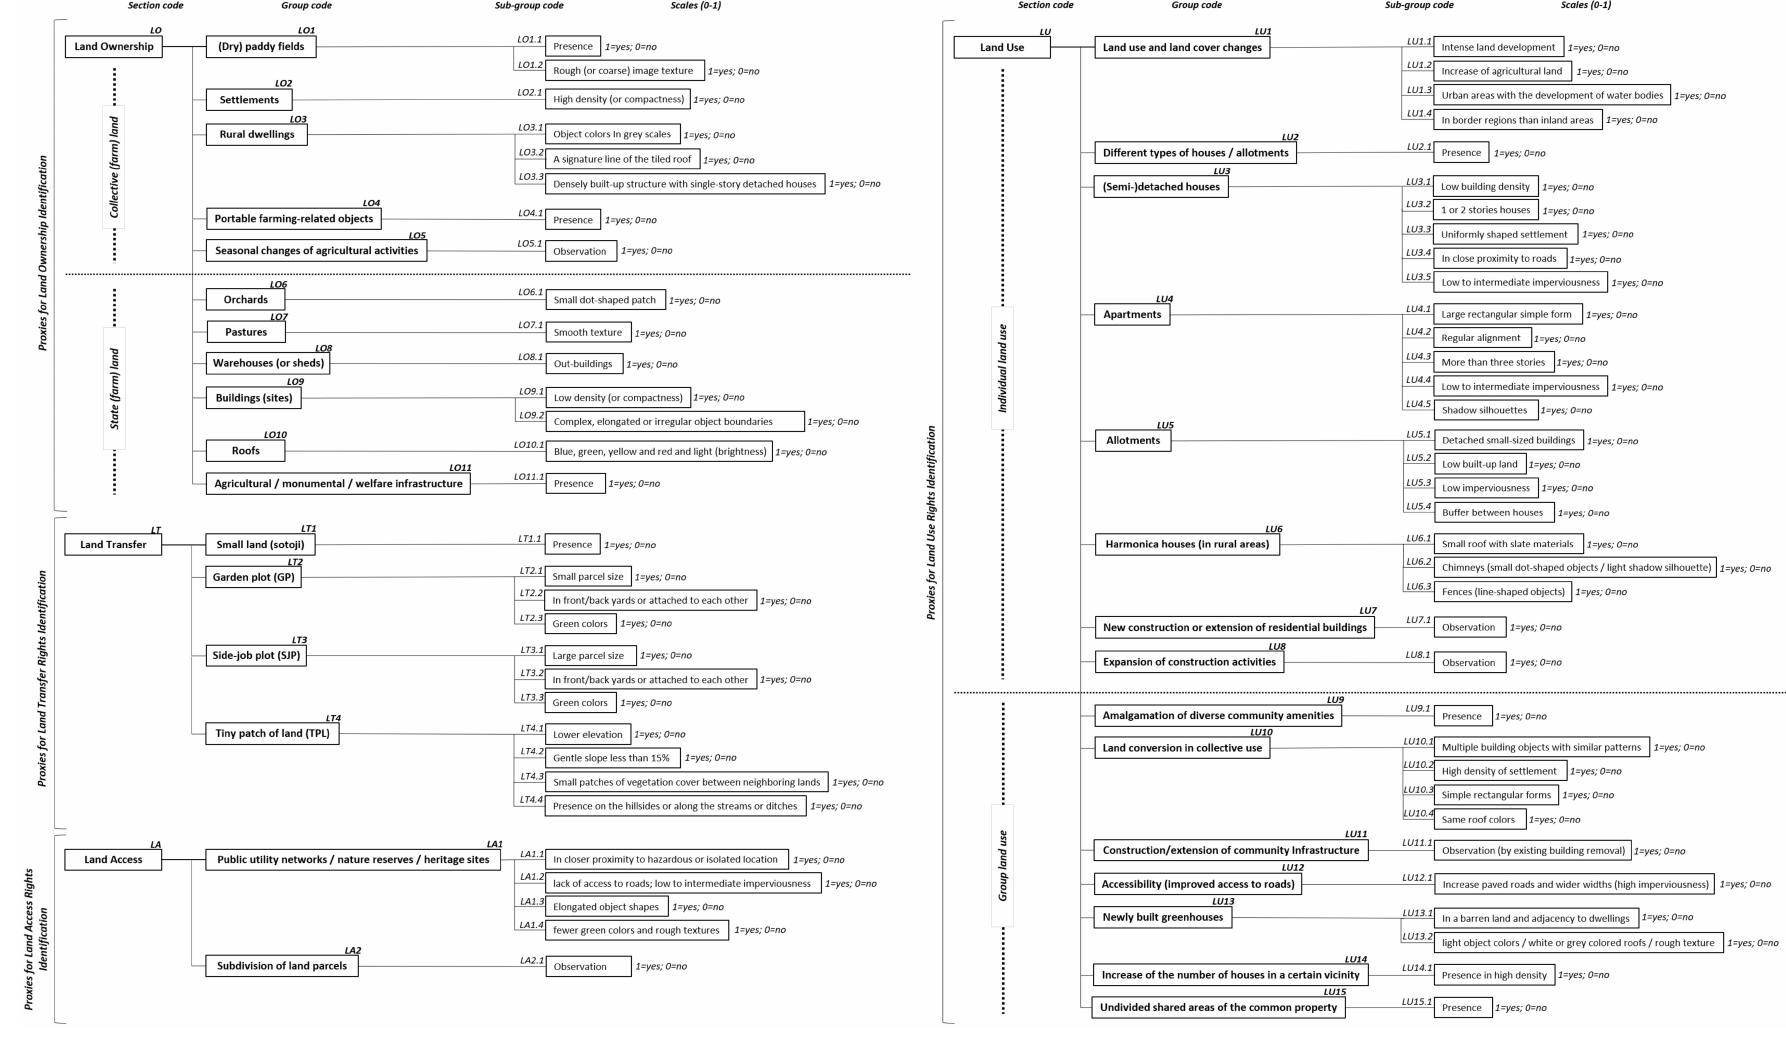
Figure 1. The organization of geospatially informed proxies on land ownership, land use, land transfer and land access rights (source: the authors, based on Lee and de Vries (2020)